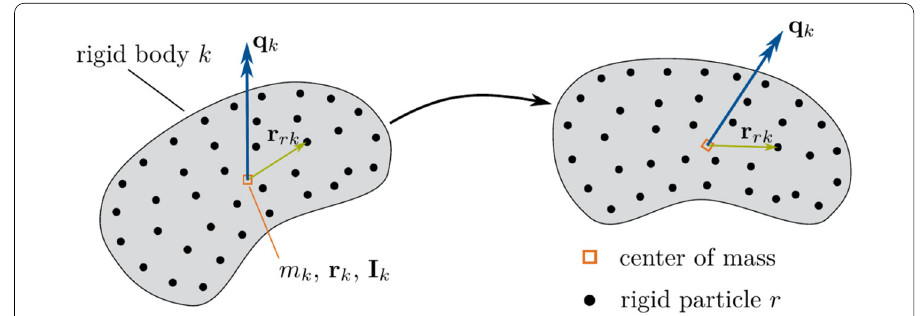
Fig. 3 Orientation of a rigid body k with rigid particles r and their relative position r rk described via a unit quaternion q k at different